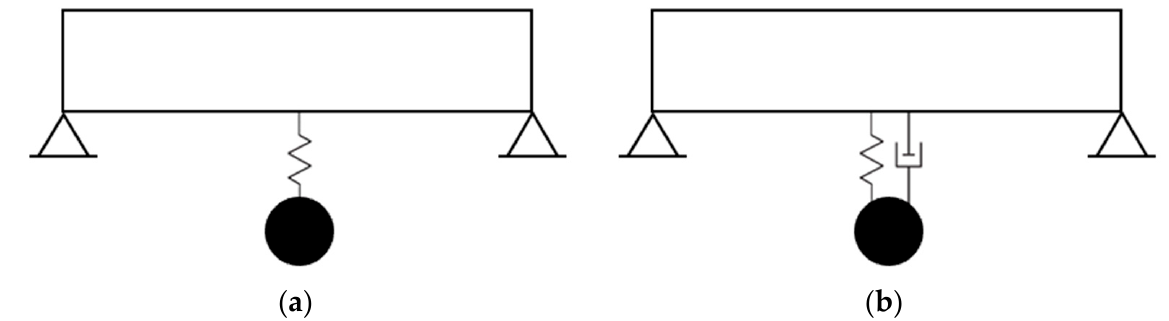
Figure 1. A single-span beam with a TMD at the mid-span. ( a ) Frahm’s vibration absorber (TMD without a self-damping). ( b ) TMD with a self-damping.